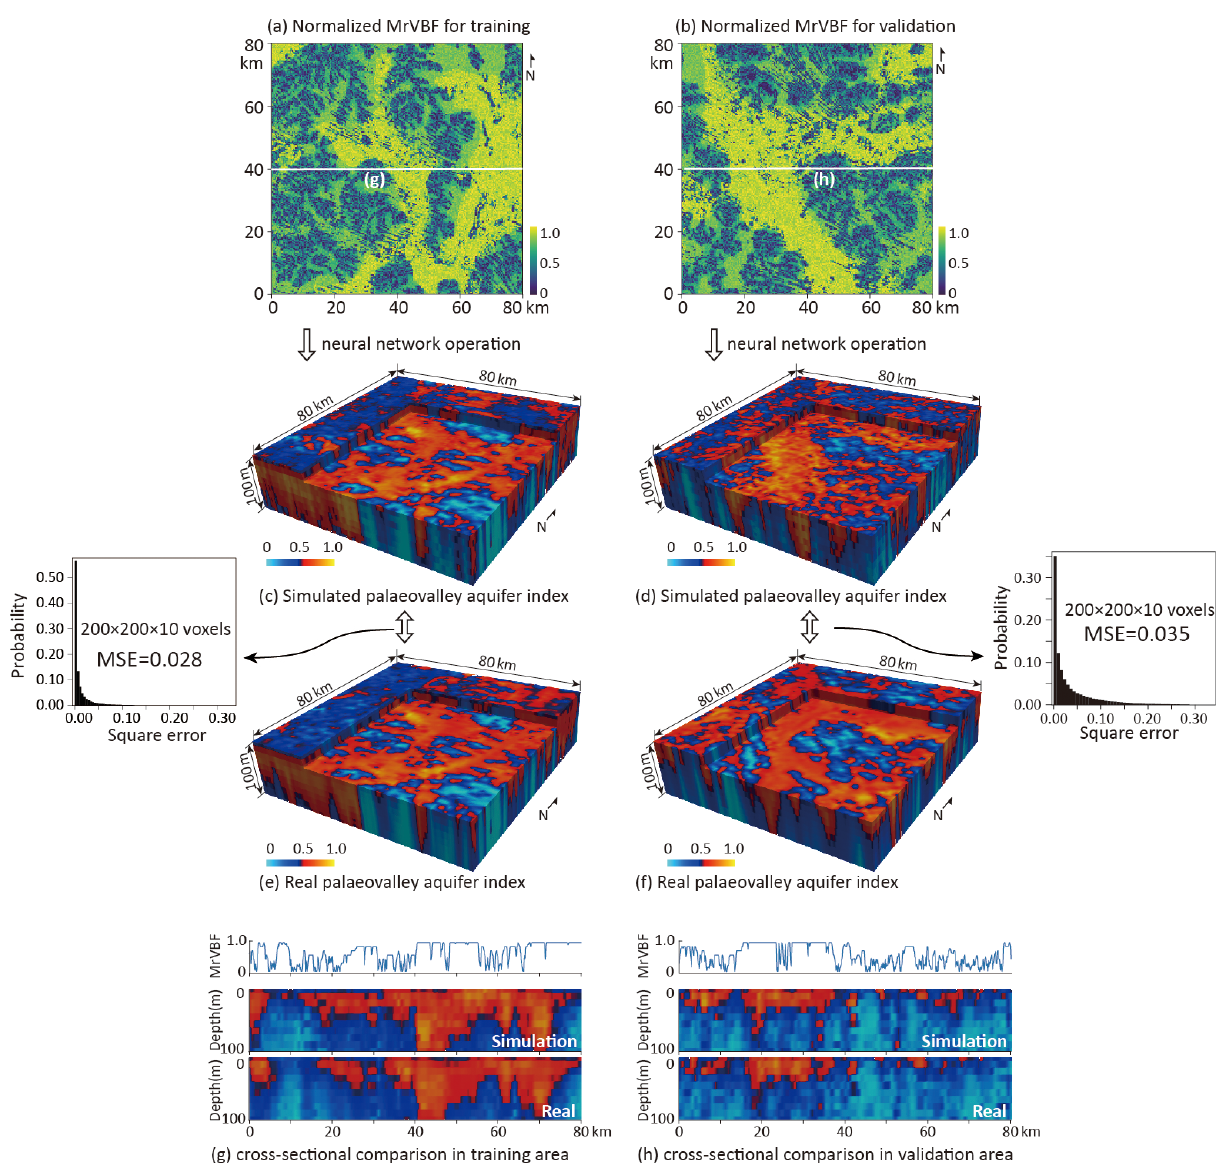
Figure 5. Normalized multiple-resolution valley bottom flatness (MrVBF) ( a and b ) converted to the 3D paleovalley aquifer index (PAI) in the training area (c) and validation area (80km west to the train area) (d) by the neural network simulator, compared with AEM-derived PAI (ground truth data) ( e and f ) generated from airborne electromagnetic surveys. Transects of simulated and real PAI and corresponding normalized MrVBF for training area (g) and validation area (h) . The trained neural network with the squared error < 0 . 10 across 99% of the training zone (a total of 200 × 200 × 10 voxels) results in a PAI error < 0 . 10 across 93% of this validation zone, with < 1% of this validation zone having errors exceeding